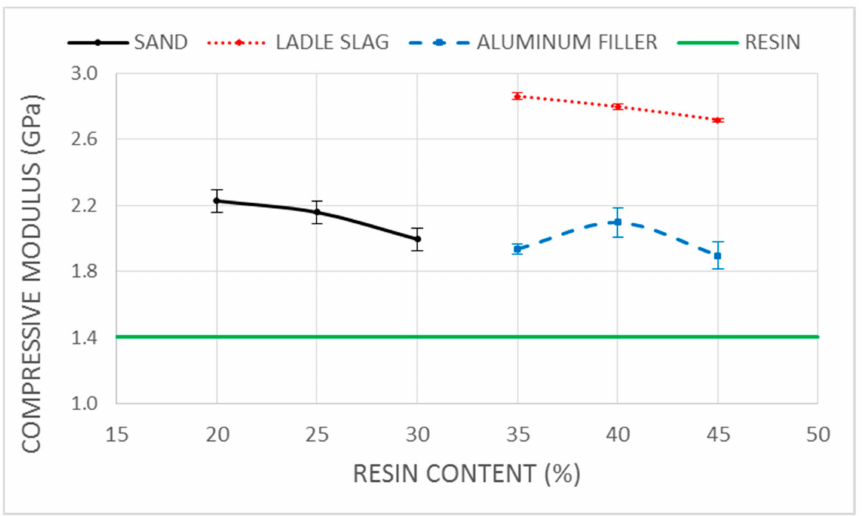
Figure 7. PPC compressive strength.